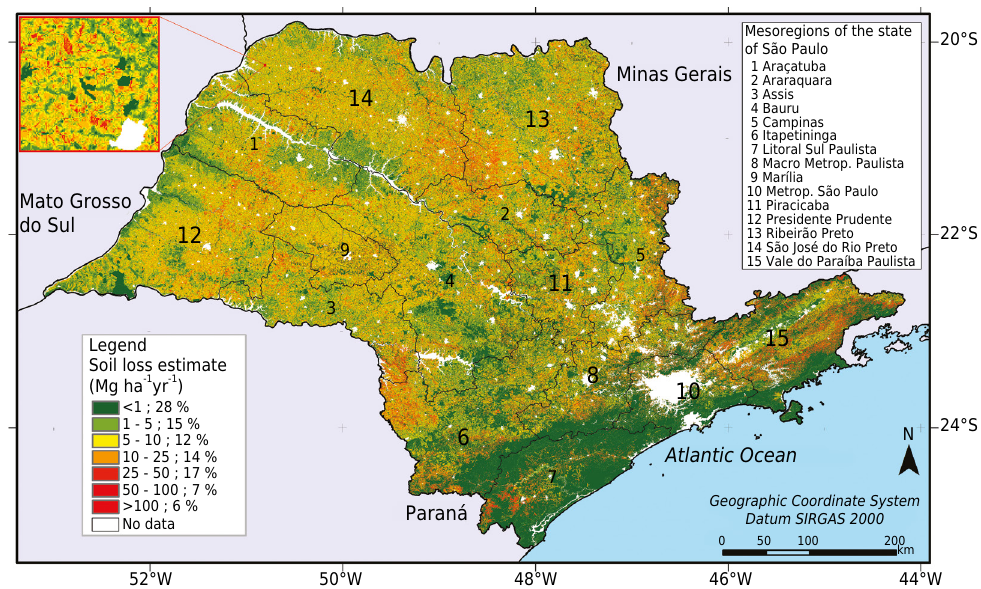
Figure 3. USLE-based map of soil loss rates in São Paulo State. Source: Medeiros et al.